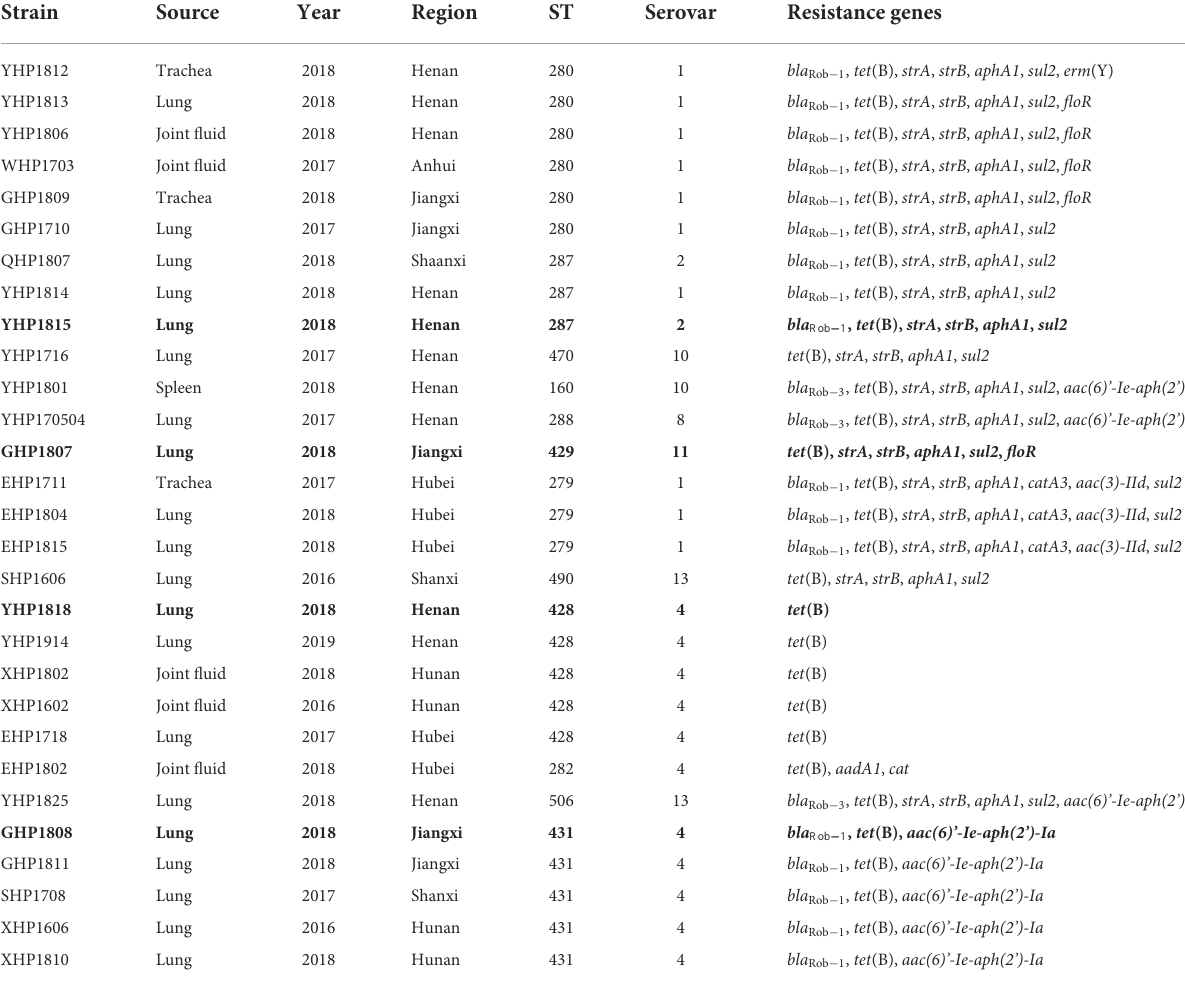
TABLE 1 General genetic features of 29 host strains carrying ICEs.